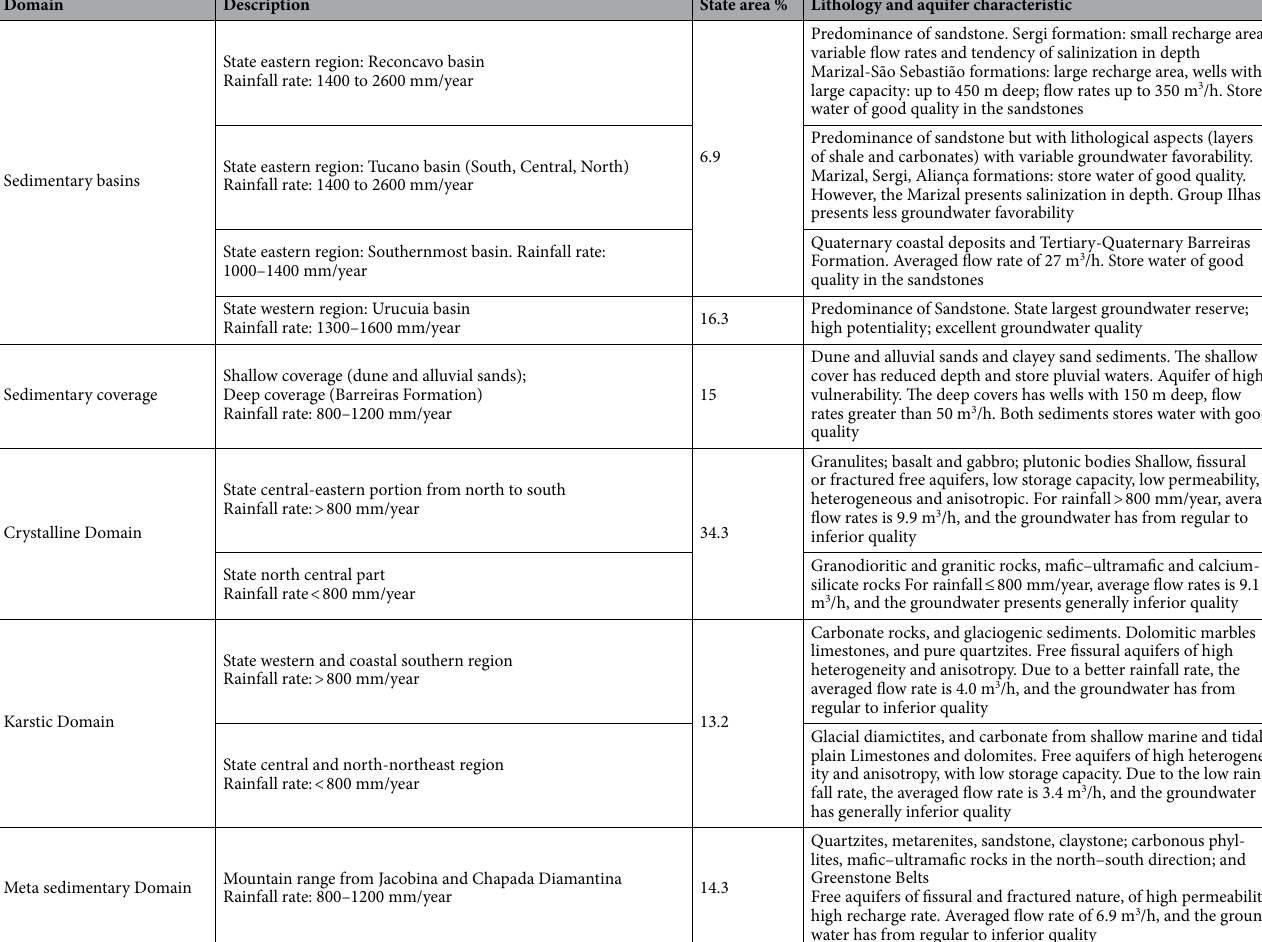
Table 1. Characteristics of the hydrogeological domains of the State of